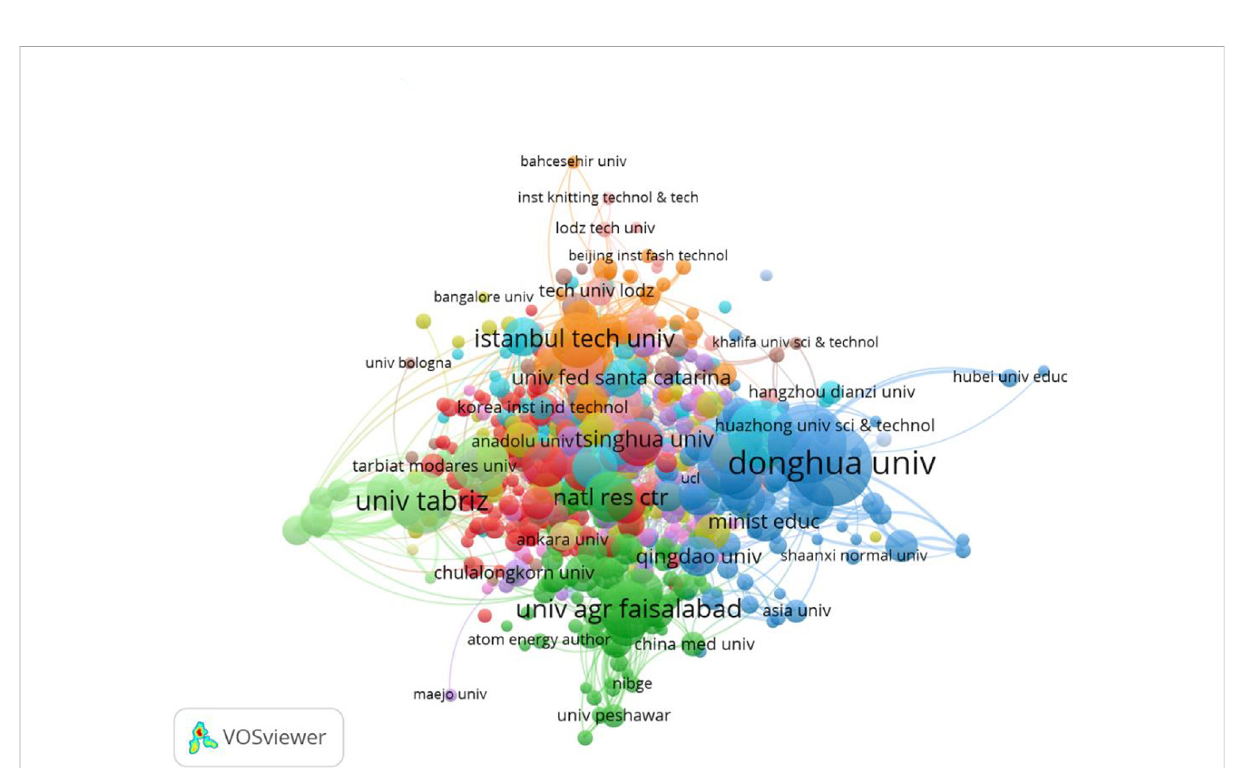
FIGURE 12 Organizational linkage is based on citations. Donghua university was linked to the maximum number of institutions.